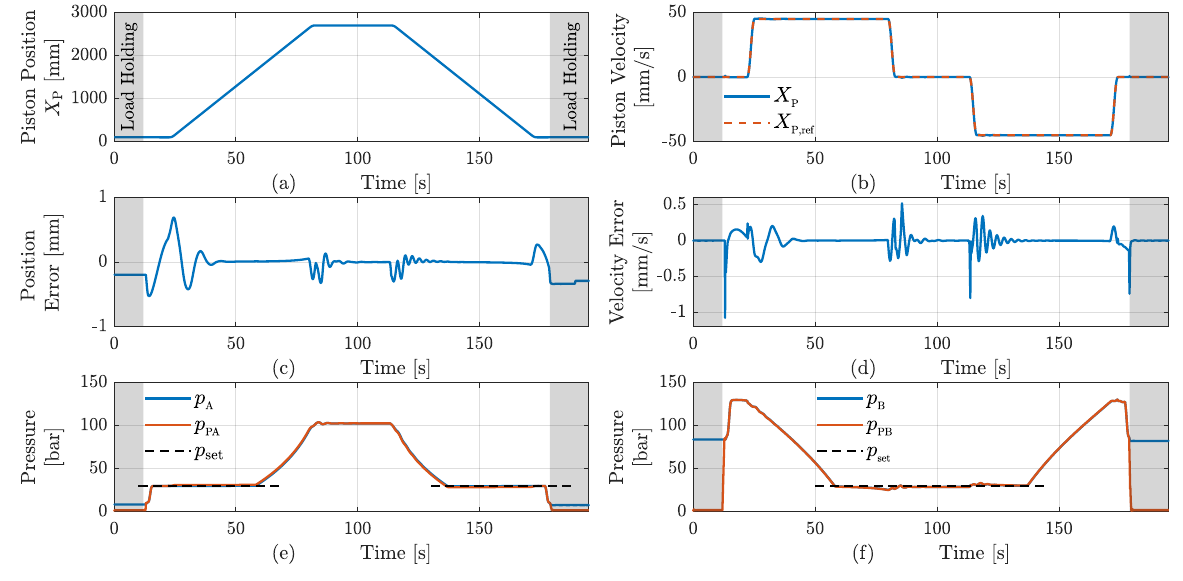
Figure 19: Performance of the proposed DvSP system performing the trajectory presented in section 3. The grey areas indicate that the system is operated in load holding mode, while being controlled in motion operation mode between these. (a) Piston position; (b) Piston velocity and reference; (c) Piston position error; (d) Piston velocity error; (e) Pressure in the piston chamber and adjacent transmission line; (f) Pressure in the rod chamber and adjacent transmission